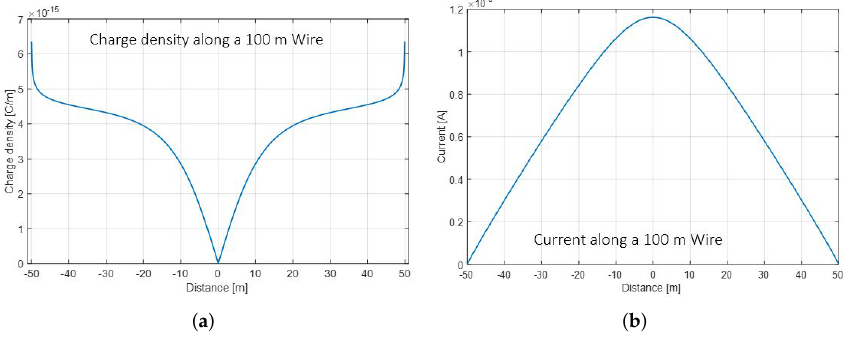
Figure 5. Method of moments model of a buried 100 m wire excited by an above-ground TX coil. ( a ) Charge density along wire. ( b ) Current along wire.